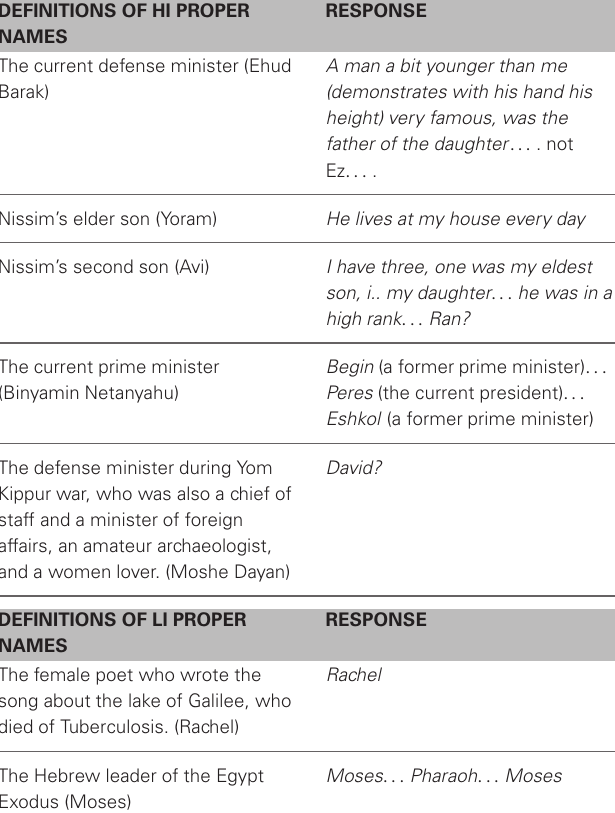
Table 3 | Examples of Nissim’s responses in the naming to definition task: high and low imageability proper